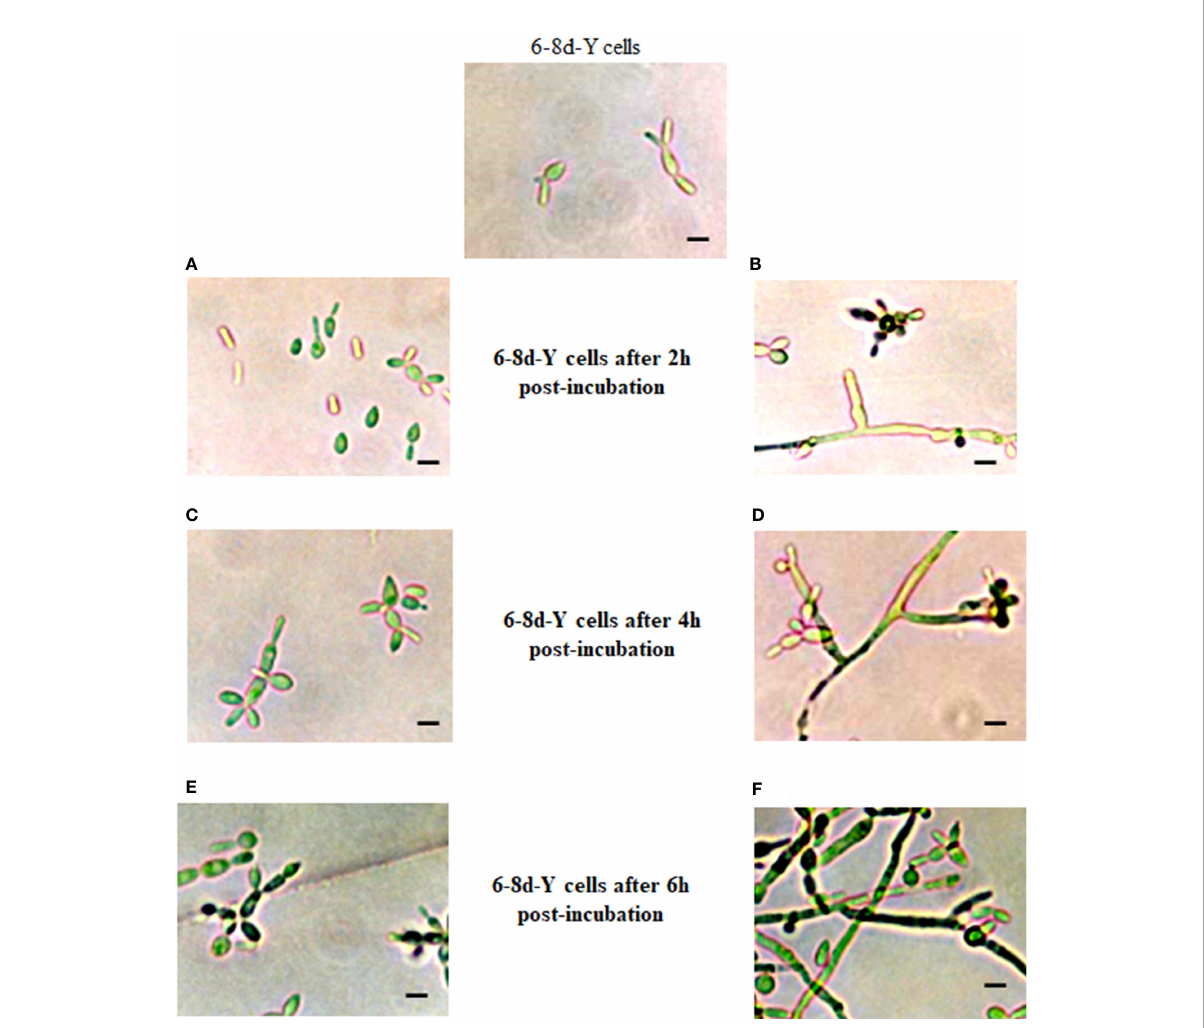
FIGURE 4 In fl uence of CR on growth and morphological development of yeast cells. A culture of yeast cells grown for 6-8 days in the absence of CR was divided into two equal portions that were post-incubated in the same conditions for 2 (A, B) , 4 (C, D) and 6 (E, F) h in the absence (A, C, E) and presence (B, D, F) of 15 m M CR. Cell morphology was inspected after the indicated times by OM. Bar, 5 m m. Reproduced from Sa ́ nchez-Lo ́ pez et al., 2019, with permission from Springer Nature, License Number 501734282 (May 24,